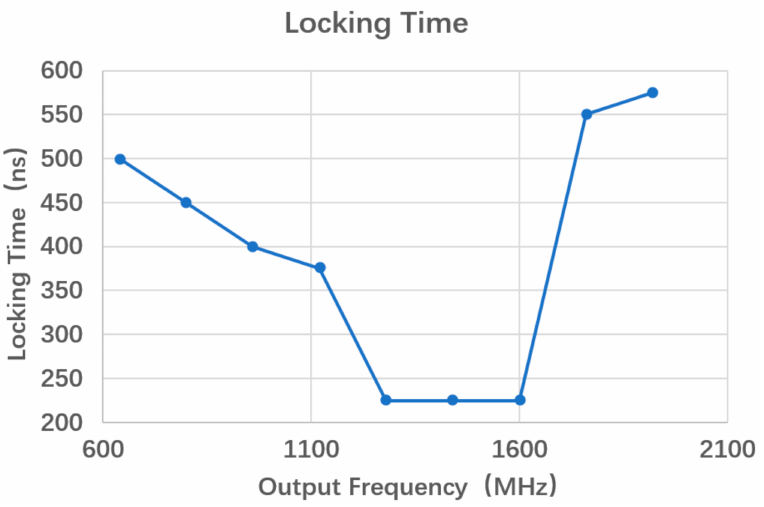
Figure 11. The locking time of the